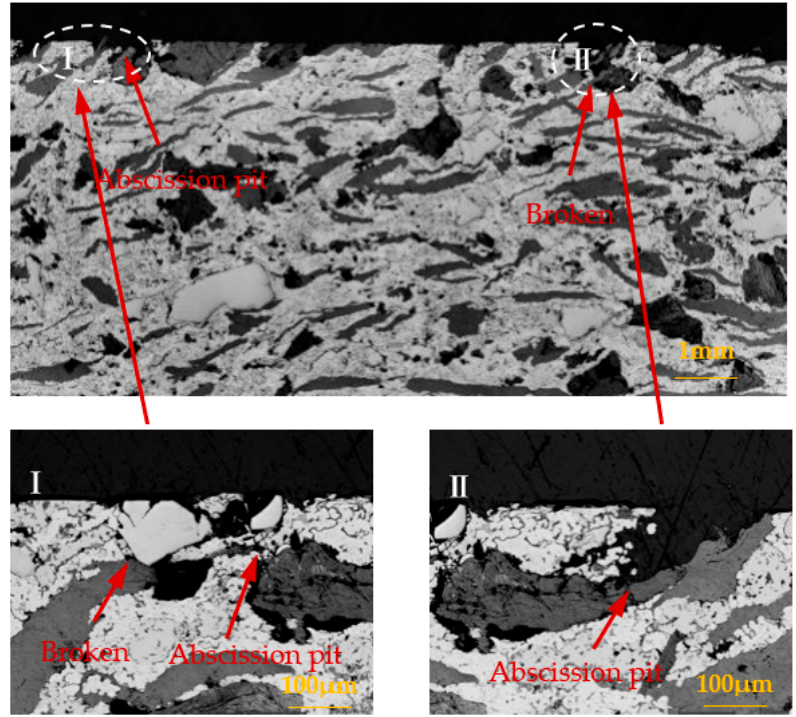
Figure 20. Profile photos of the brake pad material after intermittent brake wear at − 30 °C.